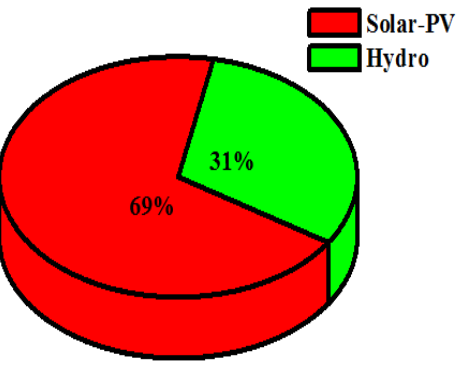
Figure 19. Renewable energy generation percentage for case III (Ba/H/S).